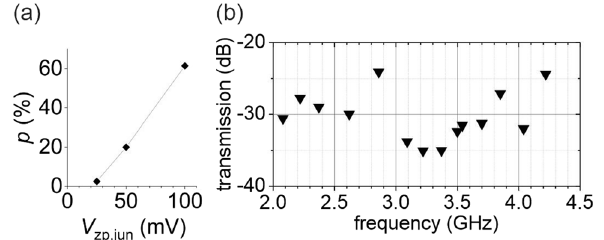
Figure 3. ( a ) Dependence of p on V RF measured at 3.37 GHz, see text. ( b ) Frequency dependent transmission of our RFSTM instrument in the bandwidth 2–4.5 GHz. Uncertainty is ± 1